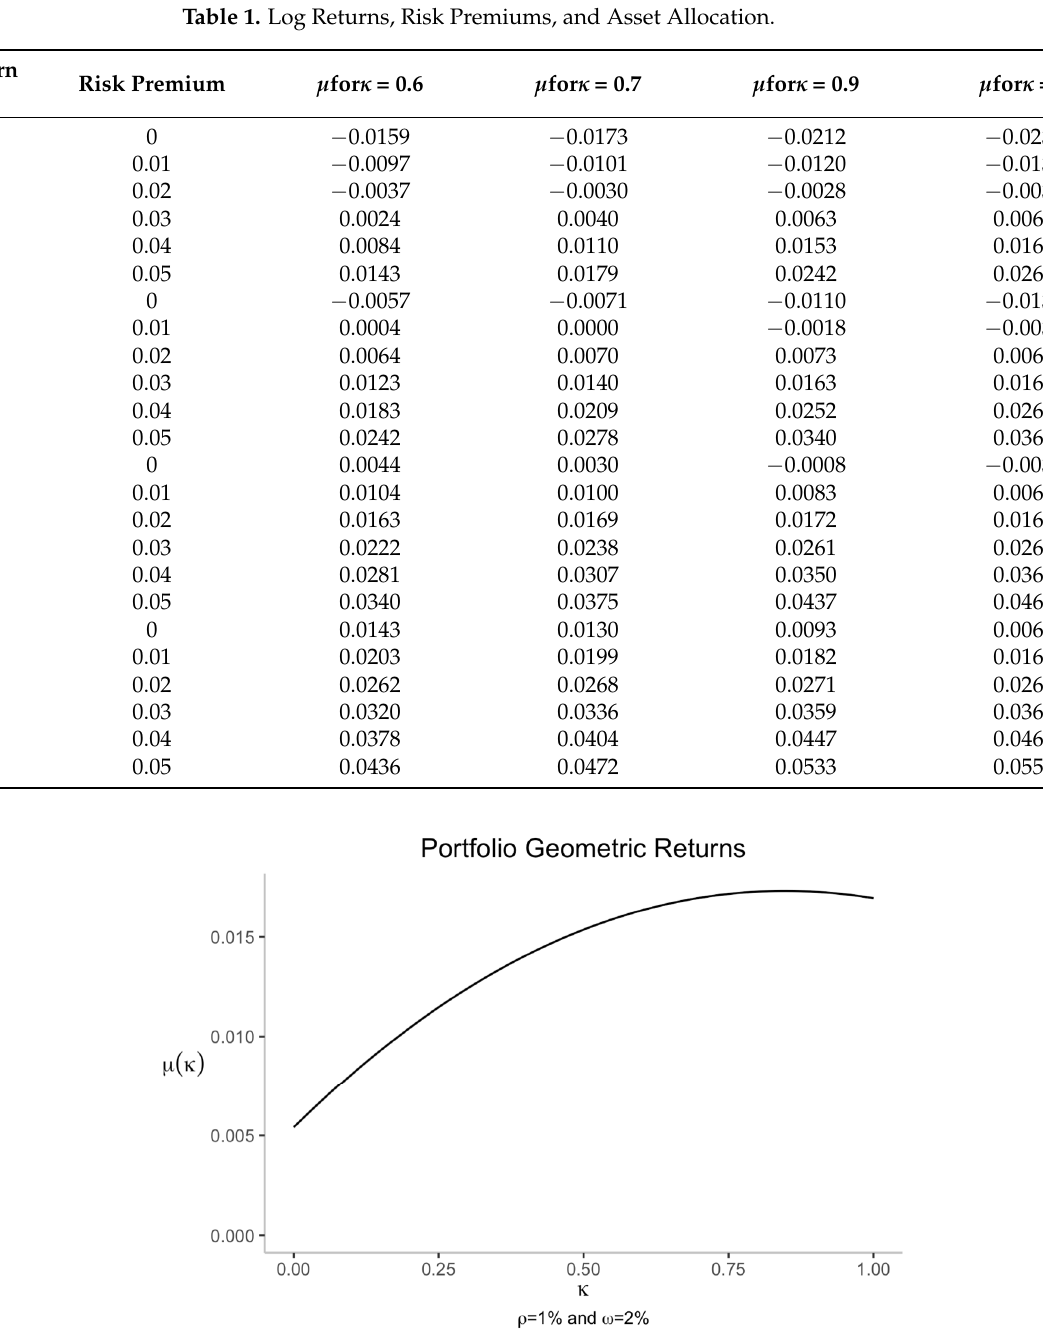
Figure 1. Portfolio Geometric Returns.